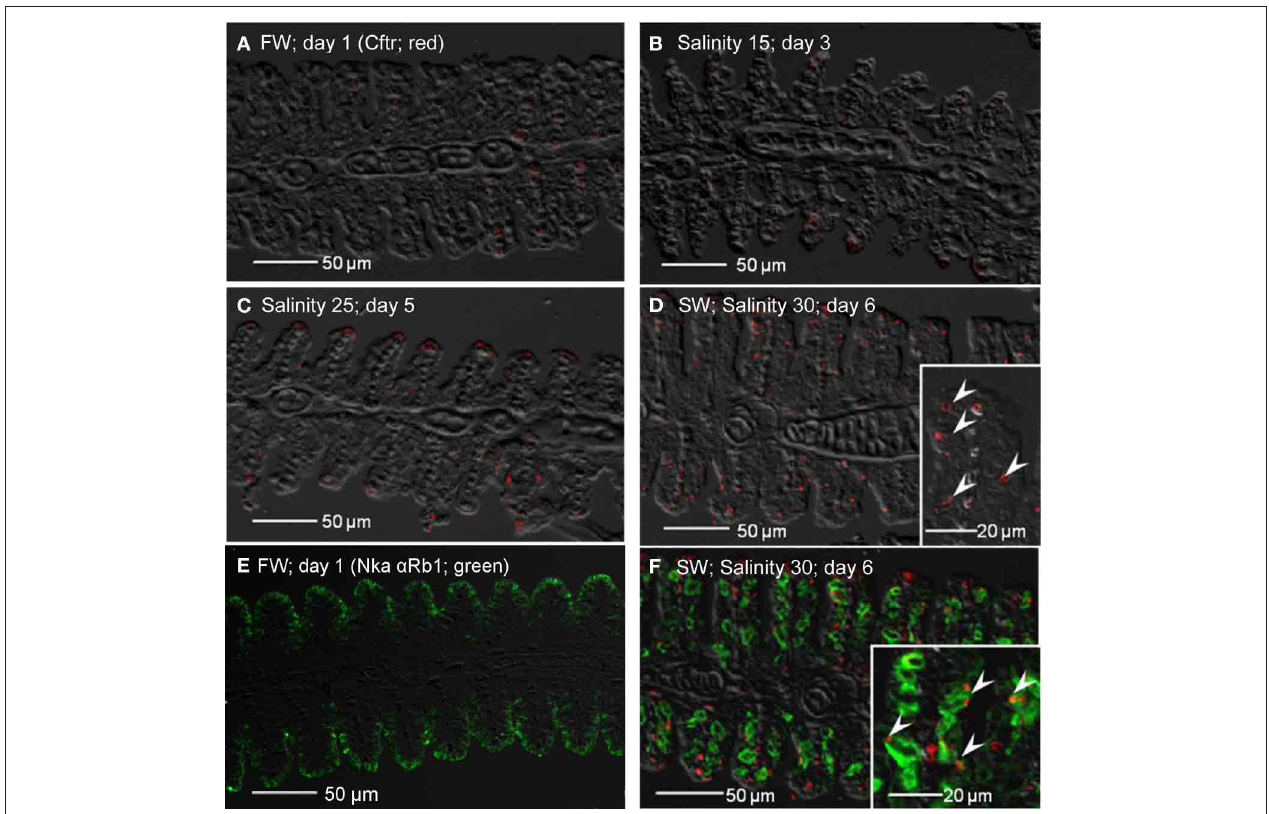
FIGURE 14 | Immunofluorescent localization of cystic fibrosis transmembrane conductance regulator (Cftr; red) in the gills of Anabas testudineus kept in (A) freshwater on day 1 (FW; control), or after 24h of exposure to (B) salinity 15 on day 3, (C) salinity 25 on day 5, or (D) salinity 30 (seawater) on day 6 during a progressive acclimation from freshwater to seawater. Double immunofluorescencestaining with anti-CFTR and anti-NKA α Rb1 (green) antibodies was performed on gills of